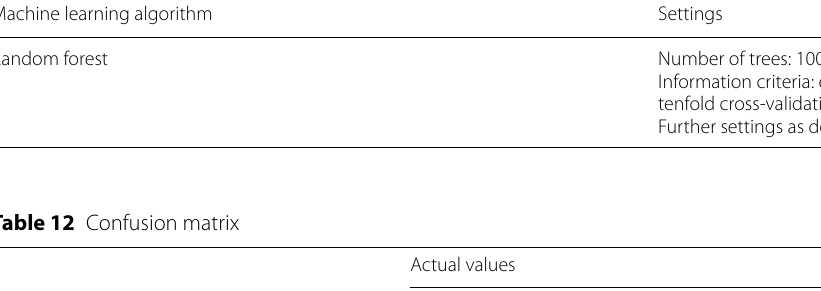
Table 11 Machine learning algorithm settings Machine learning algorithm Settings Random forest